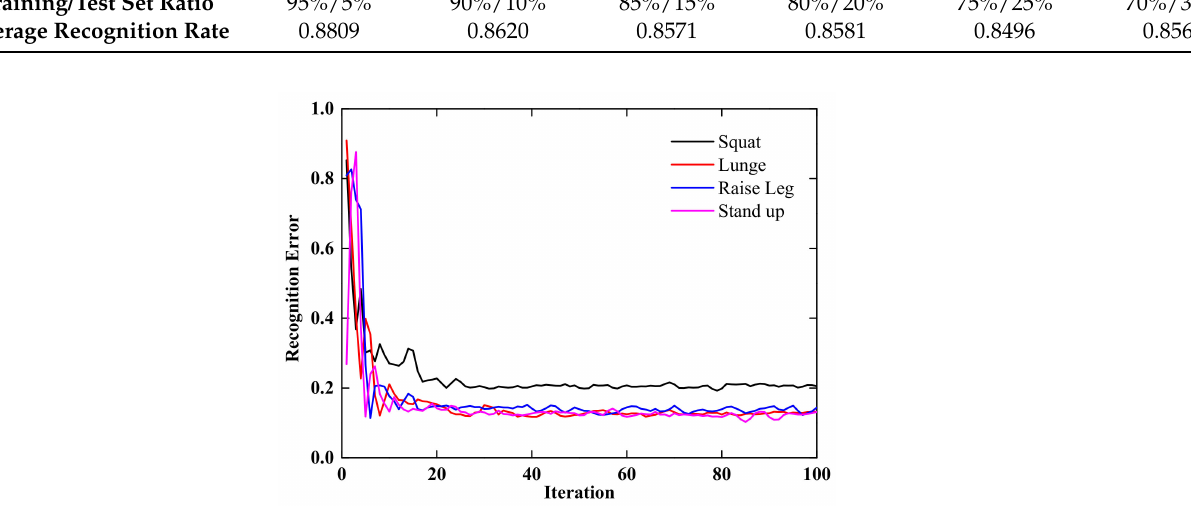
Figure 19. Training curves of the BP neural network for 4 movements.